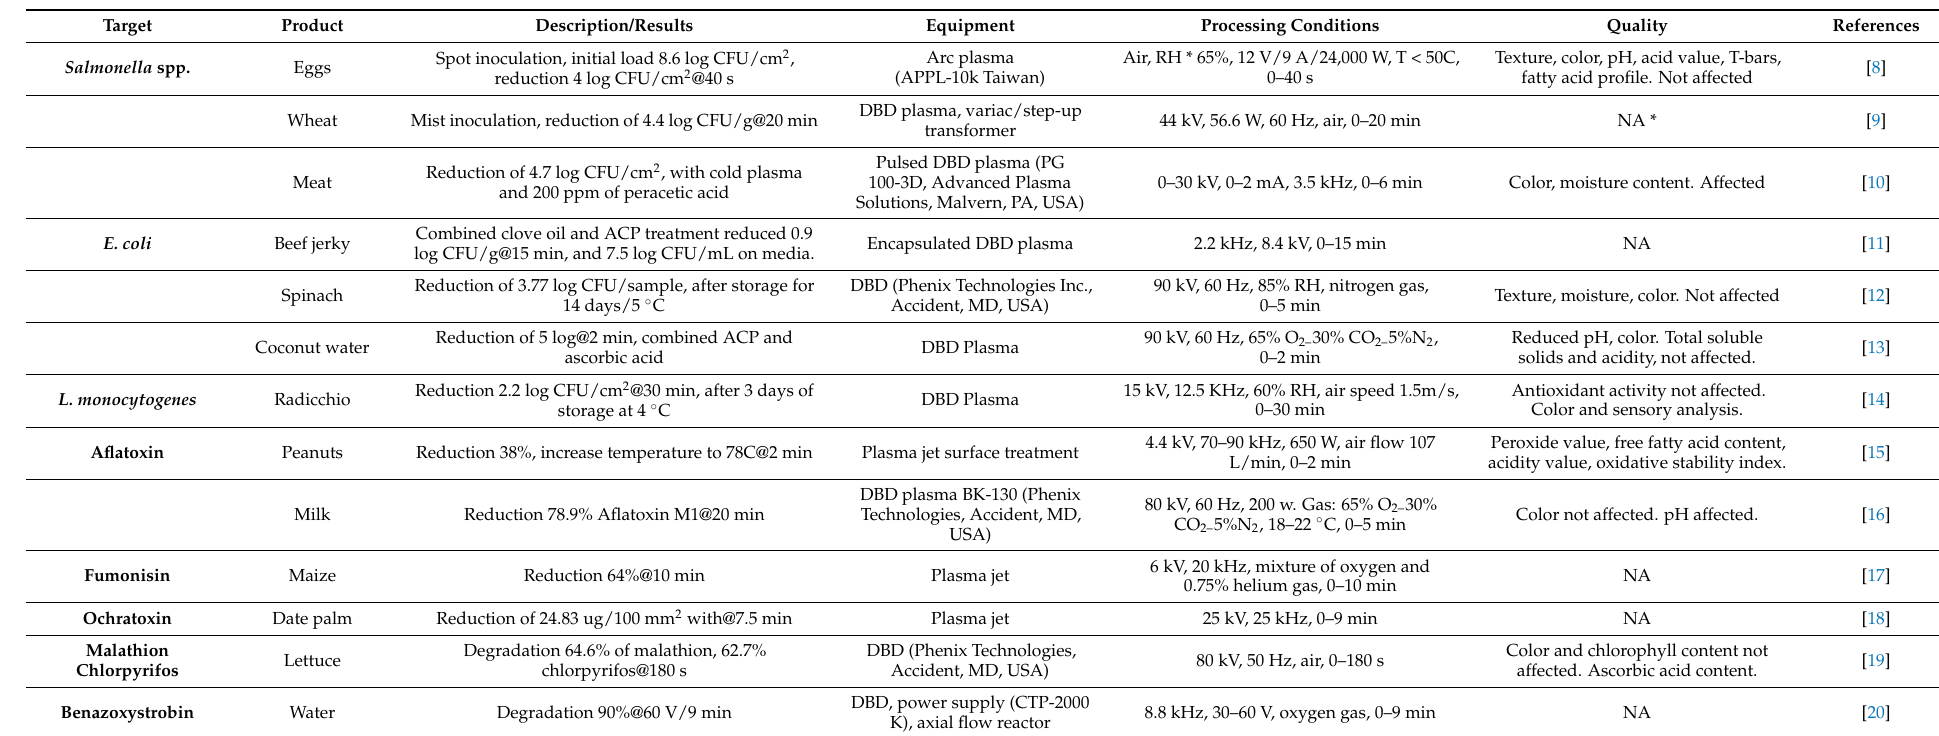
Table 1. Effect of ACP treatment on decontamination, reduction of toxins and pesticides in